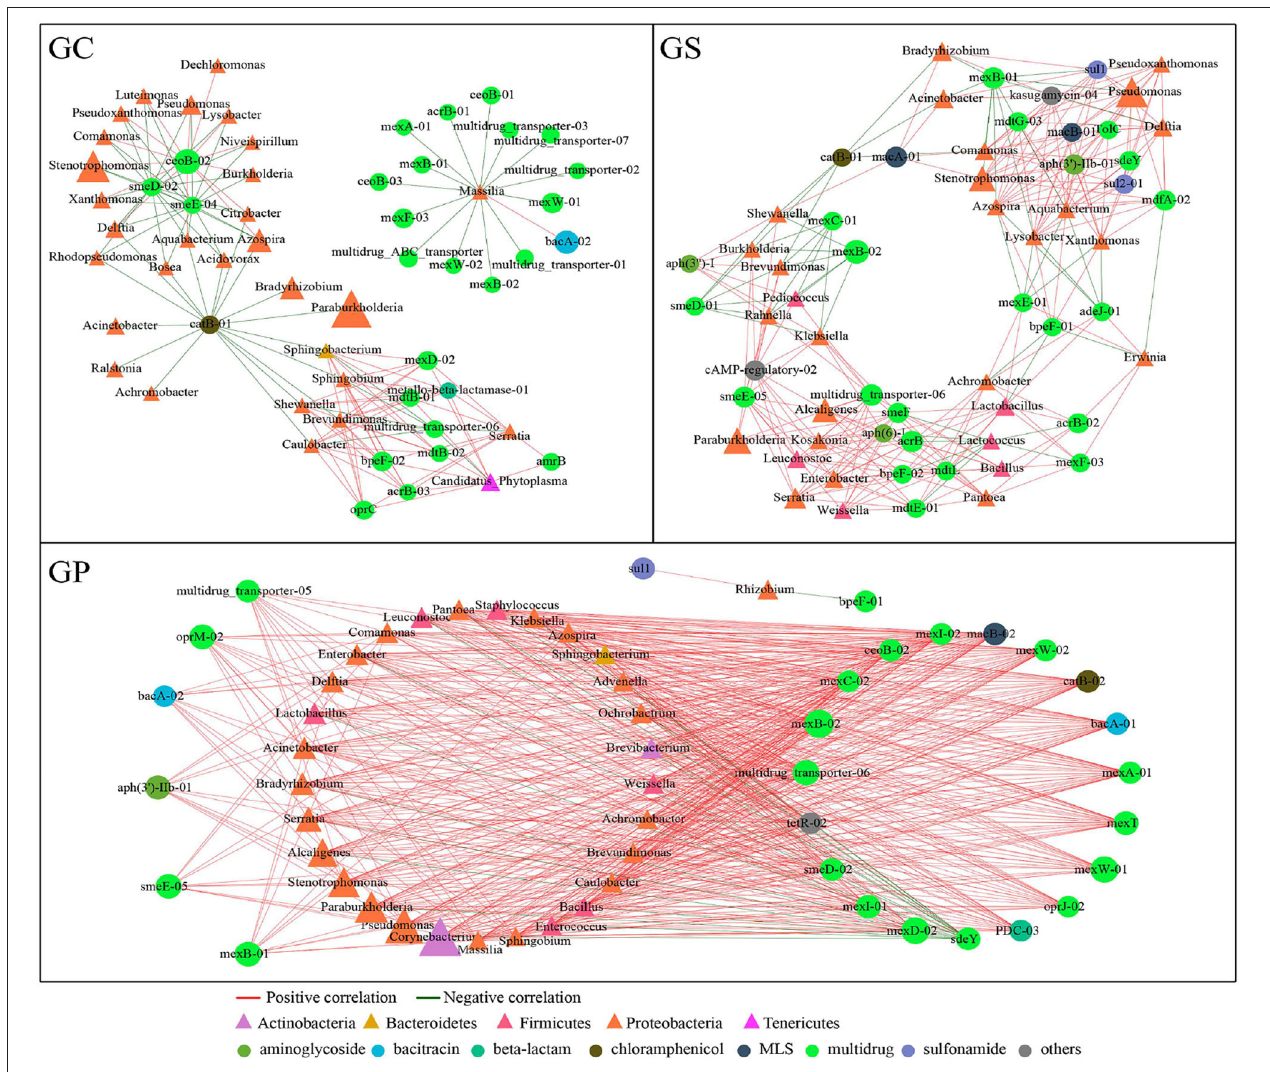
FIGURE 6 | The network analysis revealing the co-occurrence patterns among ARGs and microbial taxa. The nodes were colored according to bacterial phyla and ARG types. Edges and node size weighted were based on the correlation coefficient and the relative abundance of ARGs and bacterial communities, respectively. The edge color represents a positive correlation (red) and a negative correlation